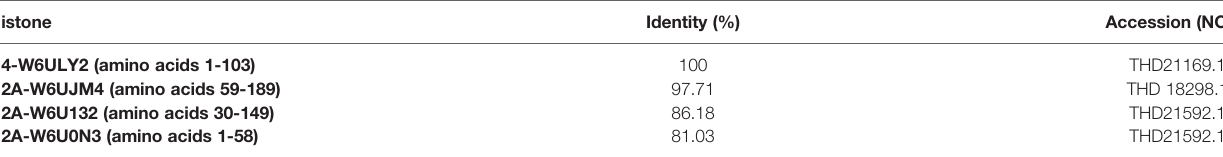
TABLE 3 | Amino acid sequence similarity with Fasciola hepatica .